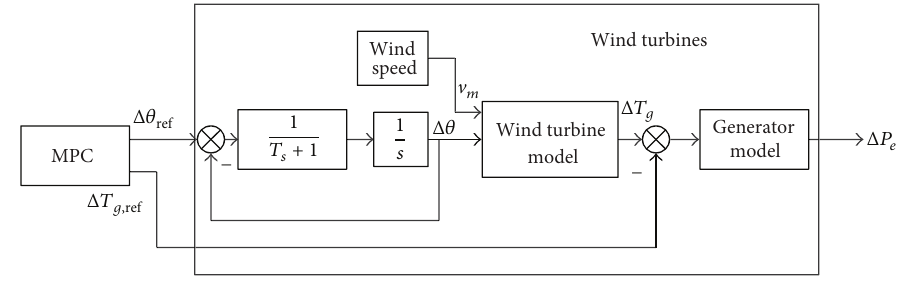
Figure 6: Diagram of wind power plant in area